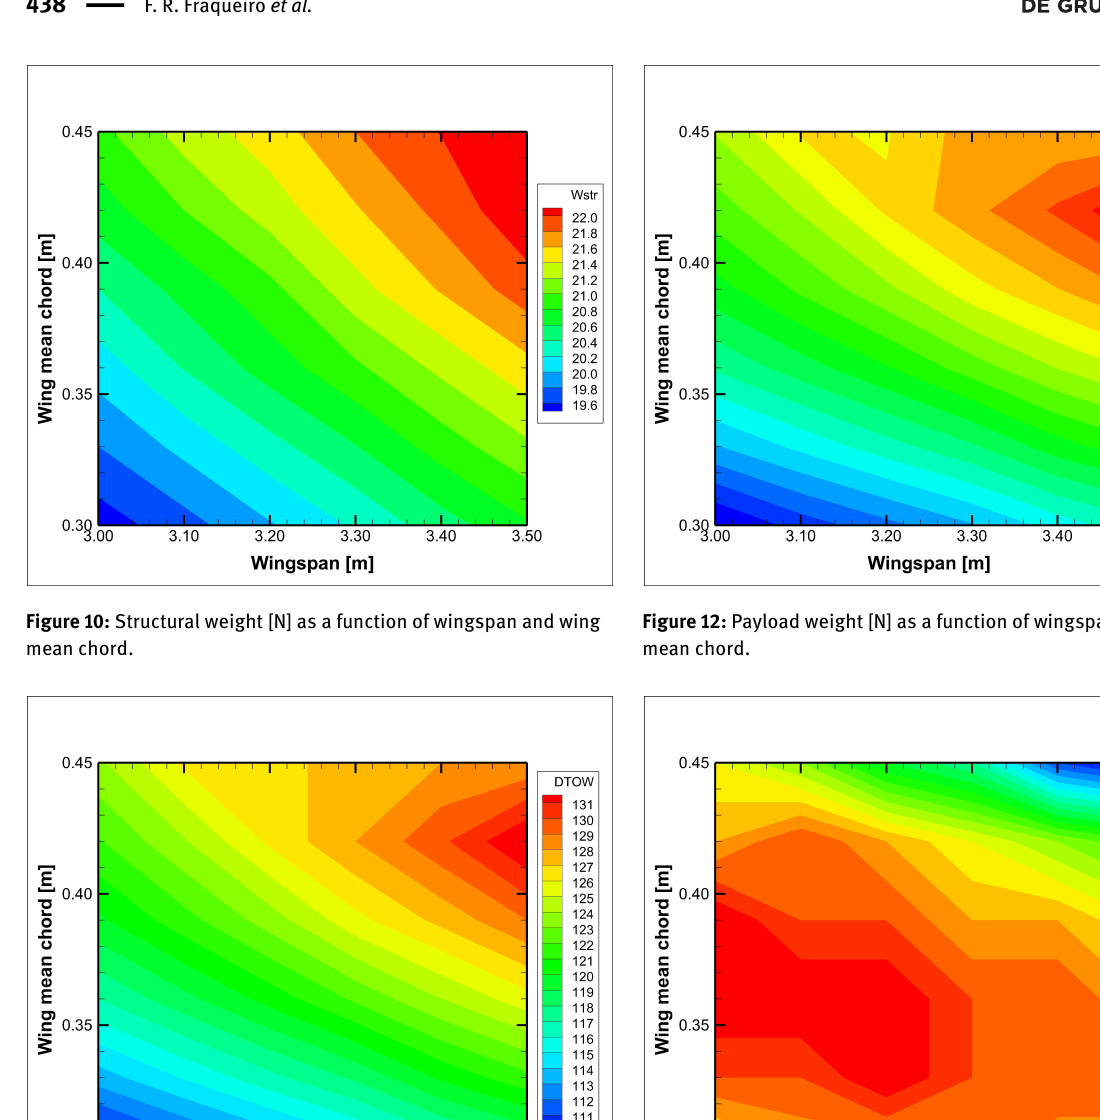
Figure 13: Number of legs flown as a function of wingspan and wing mean